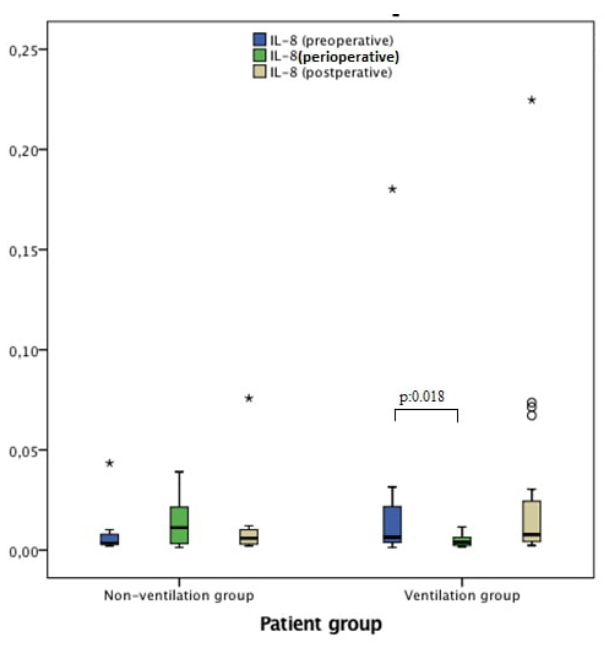
Fig. 5 - C5a measurements in preoperative (pre-CPB), perioperative (during CPB), and postoperative (post-CPB) periods.